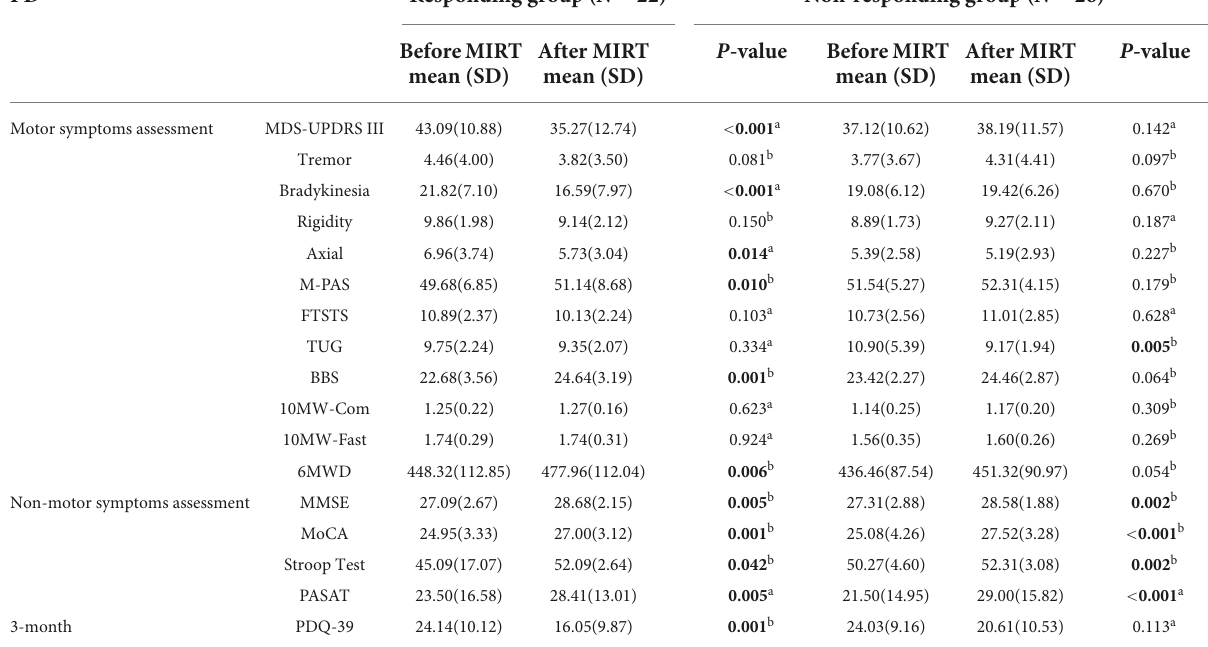
TABLE 1 Clinical characteristics of the study groups.